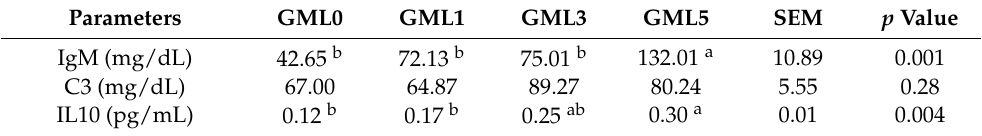
Table 6. The effect of of glycerol monolaurate supplementation on the immune status of broiler chickens.